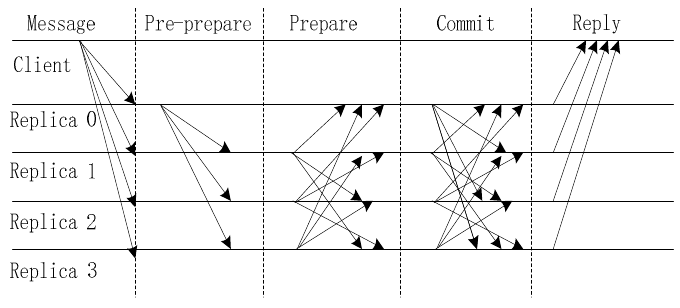
Figure 1. Basic communication pattern in PBFT (Practical Byzantine Fault-Tolerant).